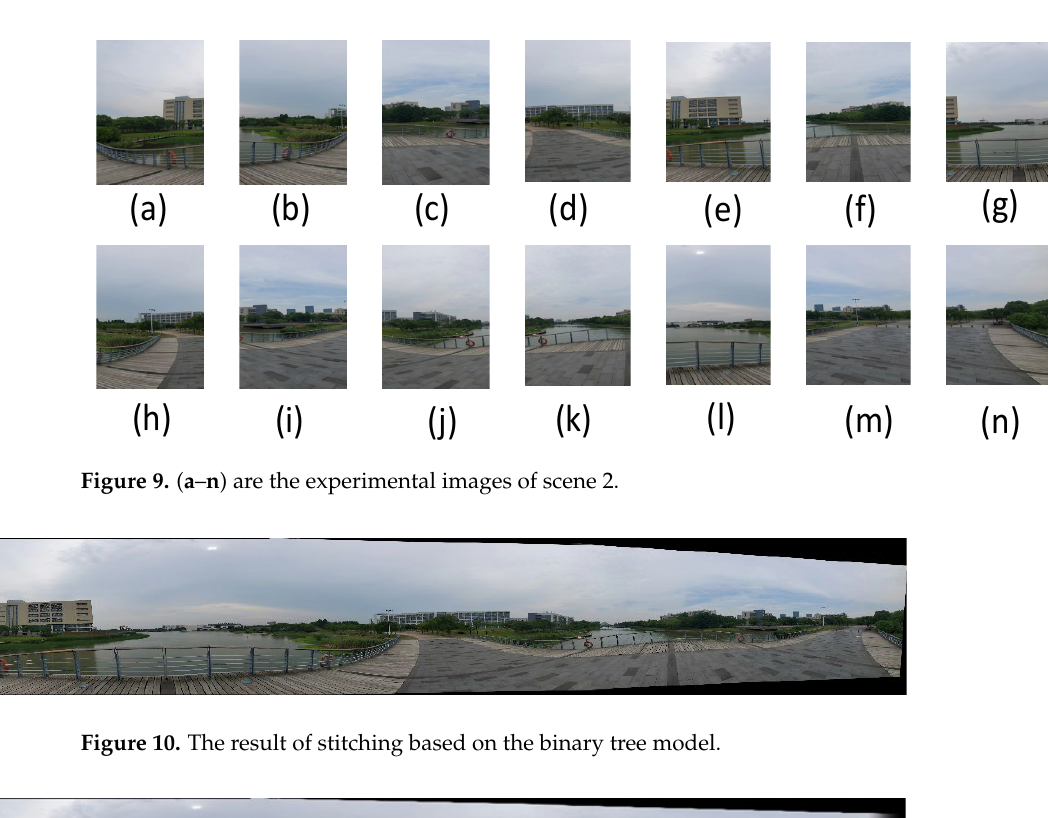
Figure 8. Results obtained with the method proposed in this paper.